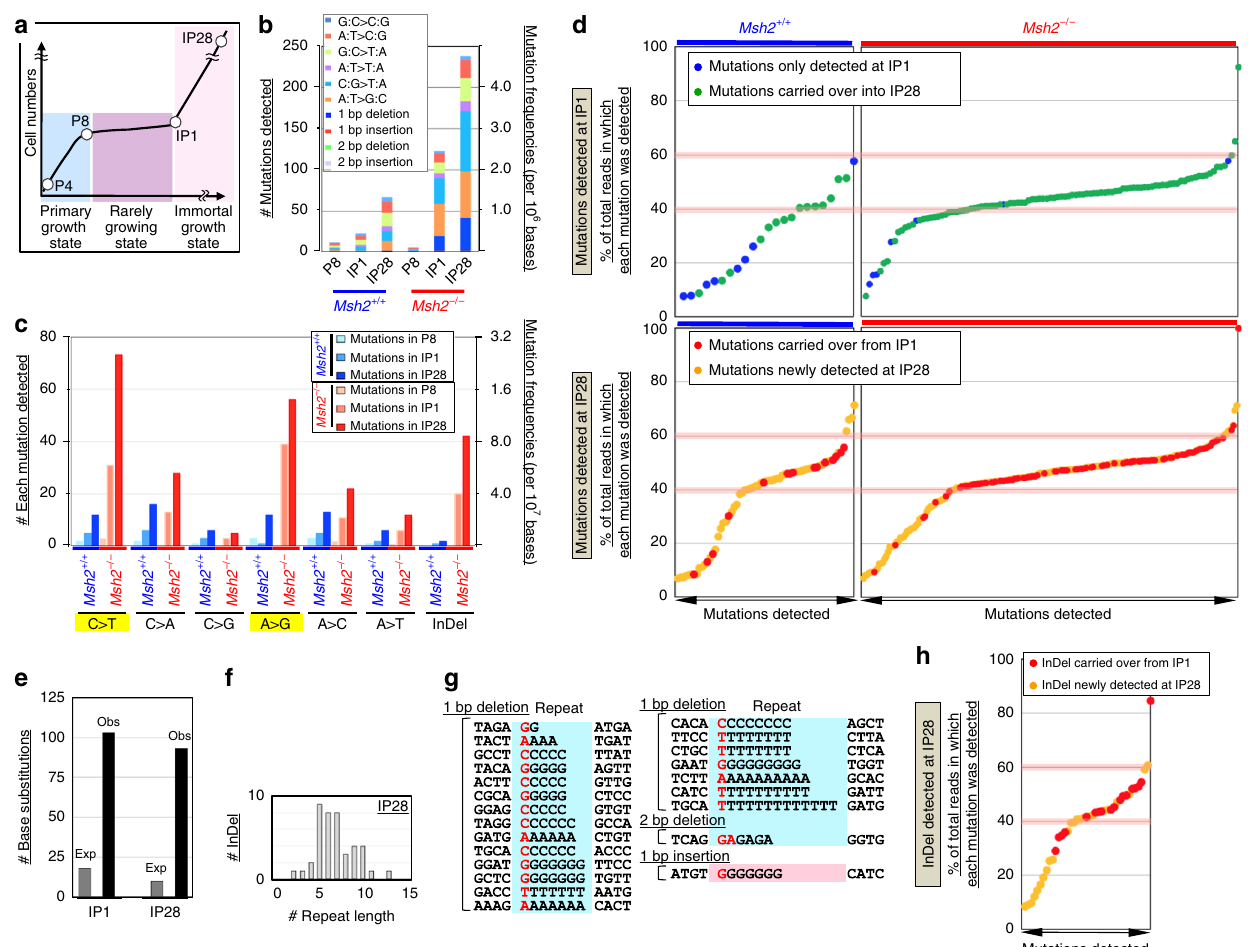
Fig. 3 Replication stress induces hypermutation and MSI in Msh2 − / − MEFs. a – c Mutations were analyzed in Msh2 + / + and Msh2 − / − MEFs at each cellular stage ( a ). Mutations detected in exons were categorized according to the indicated types ( b , c ). Mutations inducible with GT-mismatches are marked in yellow. InDel indicates In/Del mutations. d Mutations detected in exons of Msh2 + / + and Msh2 − / − MEFs at IP1 and IP28 are indicated. The percentage of total reads in which each mutation was detected is shown. e The numbers of base substitutions observed (Obs) in exons of Msh2 − / − MEFs at IP1 and IP28 are indicated and compared with the numbers expected (Exp) based on replication errors. f , g In/Del mutations detected in Msh2 − / – MEFs were analyzed. Sequences around inserted/deleted bases in immortalized Msh2 − / − MEFs. The repeat numbers of insertions/deletions ( g ) and sequences